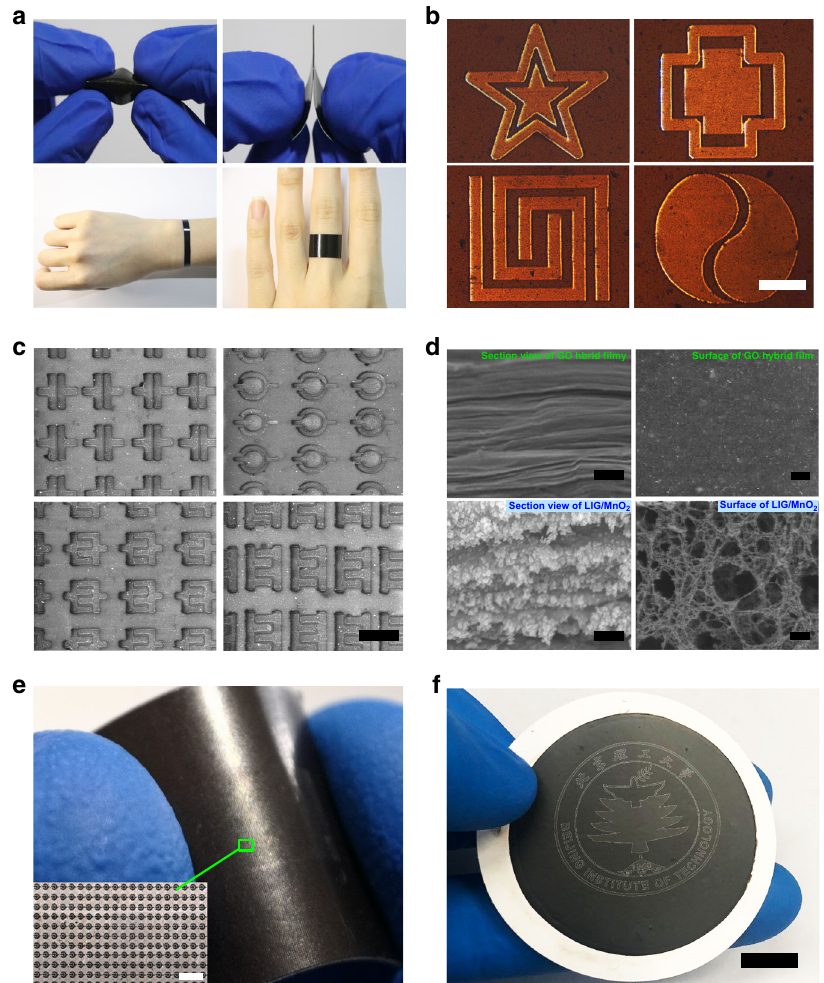
Fig. 2 Preparation of GO composite fi lms, and characterizations of the LIG/MnO 2 MSCs. a Photographs of bent and folded GO hybrid fi lm supported by vacuum extraction with different shapes which can be used for wearable energy storage device. b Optical micrographs of personalized electrode pattern processed by SSFL strategy (scale bar, 50 μ m). c The SEM image of MSCs with different shapes (scale bar, 50 μ m). d SEM image of cross-section and surface view of the GO hybrid fi lm before and after shaped laser ablation (scale bar, 100 nm). e More than 30,000 MSCs are fabricated in the 1 cm 2 (scale bar, 150 μ m). f More than 100,000 MSCs form a pattern of the school badge (scale bar, 5